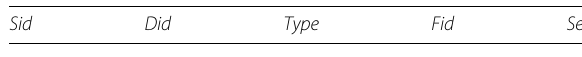
end-to-end delay are the average value of three times sim- ulation. In the simulation, the following metrics are used for our performance evaluation: Average network throughput : the average